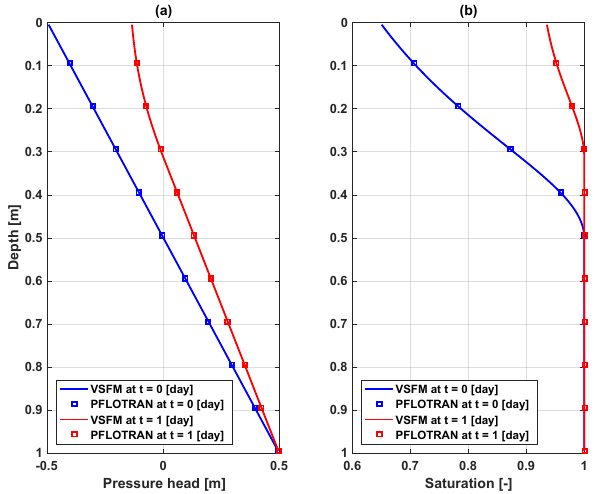
Figure 3. Transient (a) liquid pressure and (b) soil saturation simu- lated by VSFM (solid line) and PFLOTRAN (square) for the water table dynamics test problem.